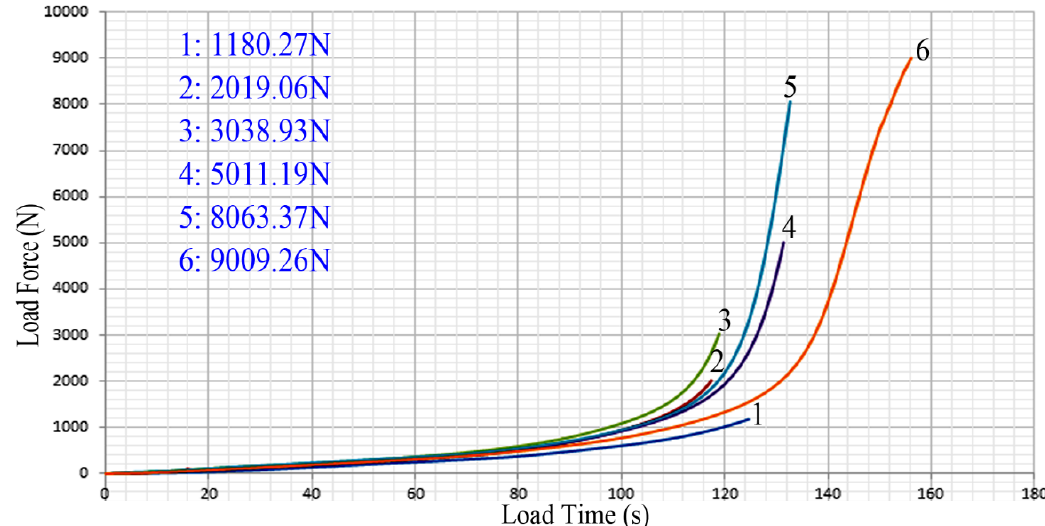
Figure 4. The load